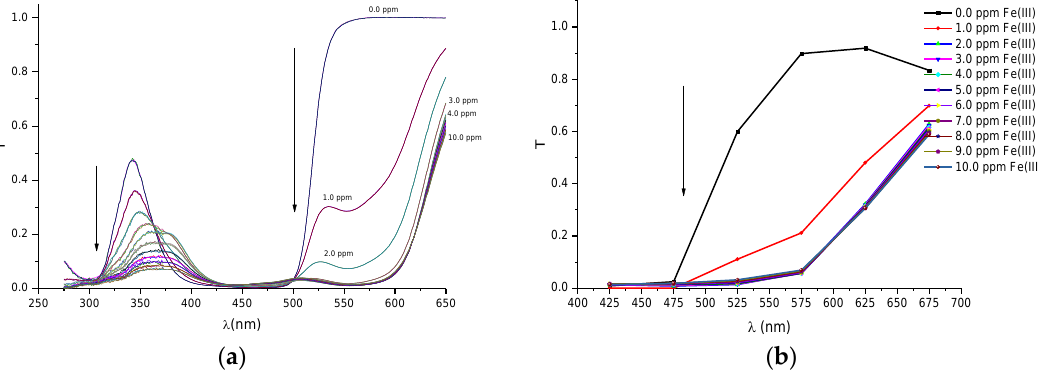
Figure A5. The transmittance spectra of the chromogen reagent of 1-(2-pyridylazo)-2-naphthol (PAN) solution containing Fe(III) ions at different concentrations corresponding to: ( a ) The UV-VIS Cary ® 50-Varian spectrometer ( b ) the multiespectral MMCS6CS sensor.